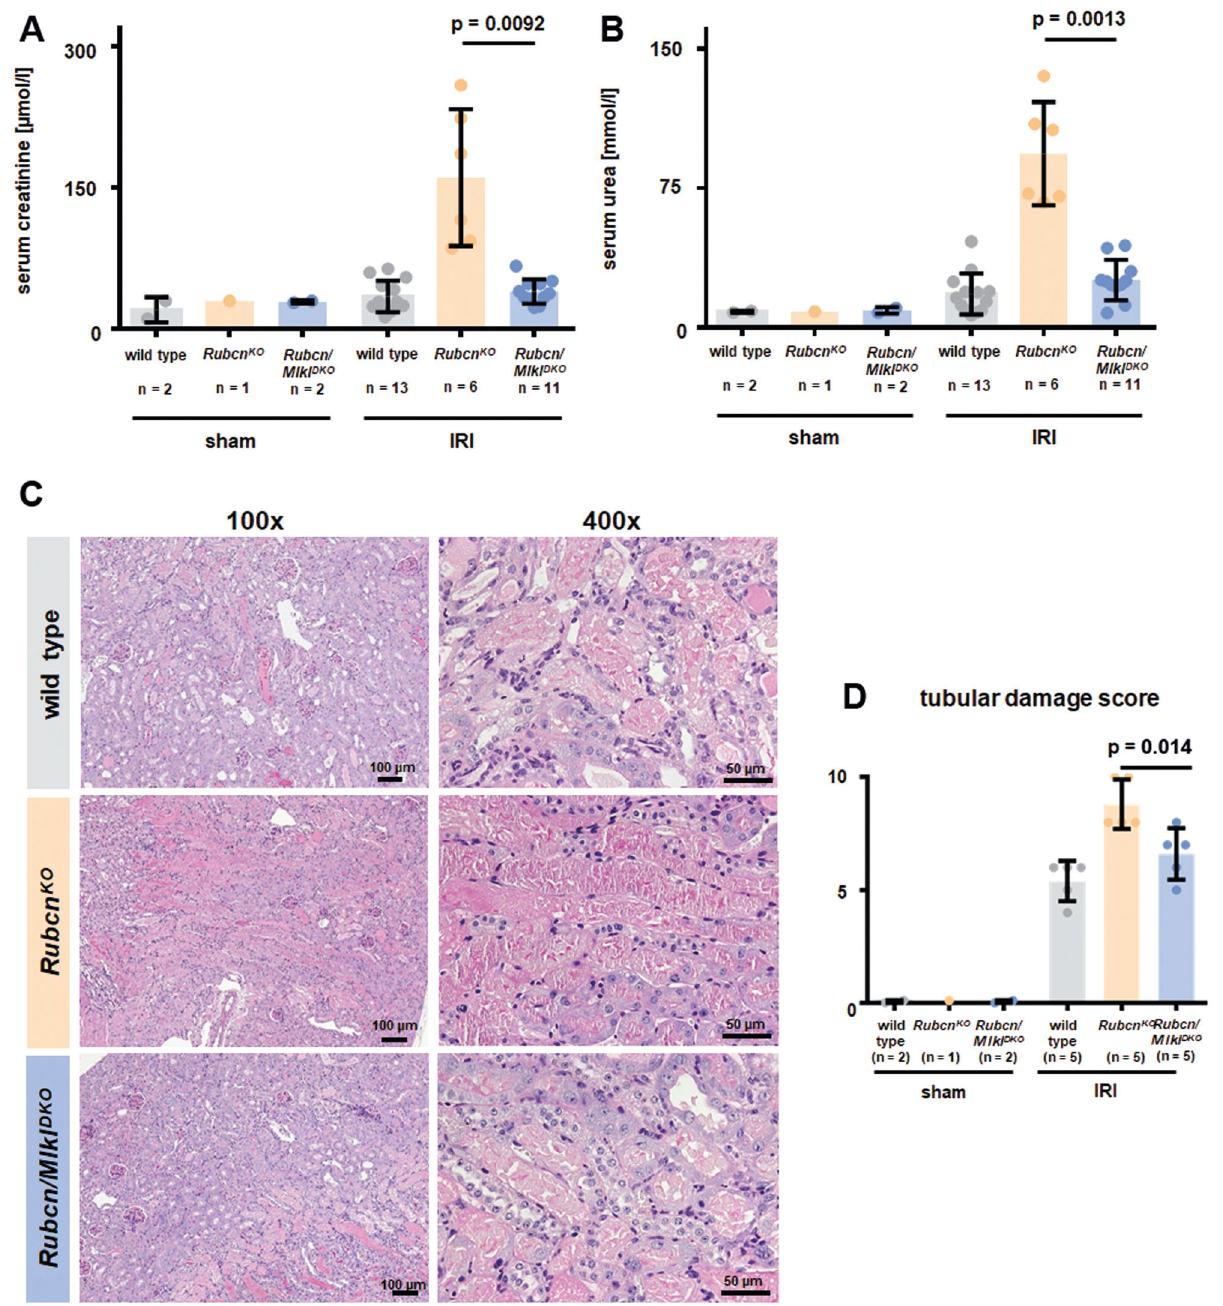
Fig. 2 The hypersensitization of RUBCN-de fi cient mice is partially reversed on a combined RUBCN/MLKL-double-de fi cient background. Indicated 8 – 12-weeks-old male mice underwent bilateral kidney IRI as demonstrated in Fig. 1. 48 h following the onset of reperfusion, serum creatinine ( A ) and serum urea ( B ) concentrations were measured and mice were sacri fi ced. Kidneys were PAS-stained and two representative magni fi cations are demonstrated in C and quanti fi ed using the tubular damage score D . Statistical analysis was performed using one-way ANOVA analysis ( p -values are indicated for each